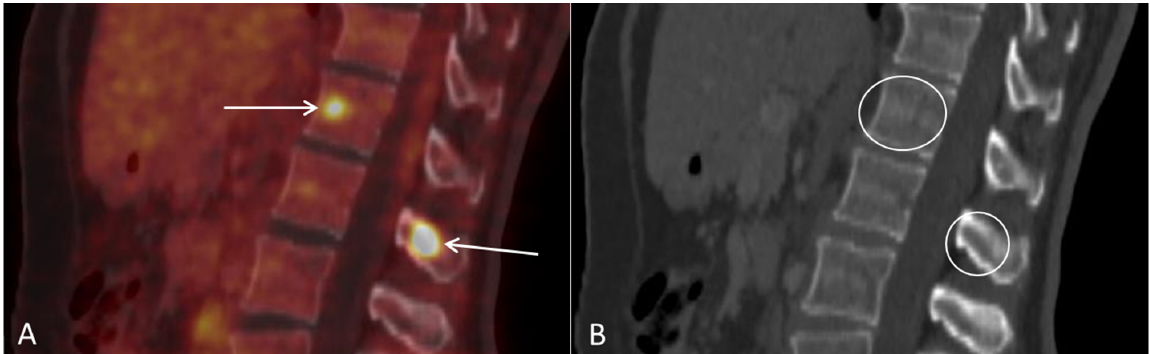
Figure 6. ( A ) Follow-up sagittal PET/CT fused and ( B ) sagittal CT after three series of chemotherapy shows metabolic activity in the spine suspicious for bone metastases ( A , arrows), with no corresponding lesions on CT ( B , circles).